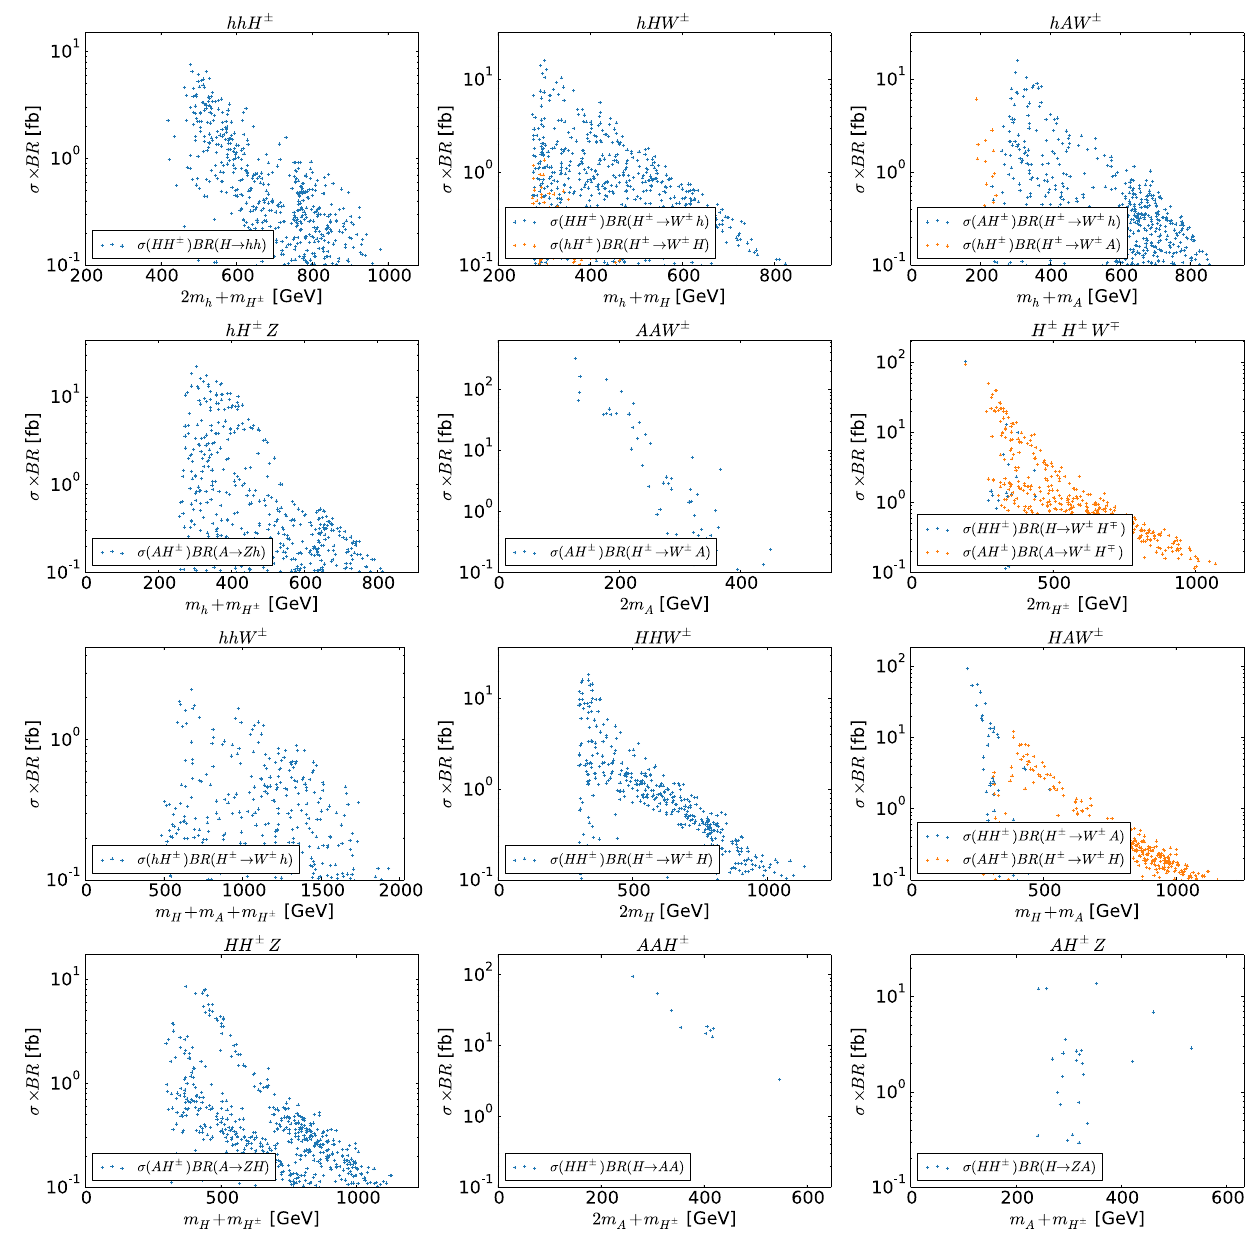
Fig. 2 Cross sections of qq (cid:2) -initiated subprocesses for selected charged